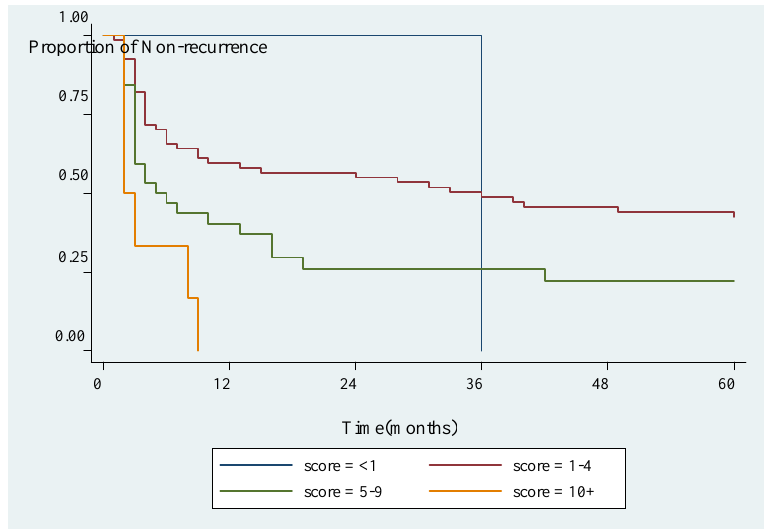
FIGURE 1. Time to first recurrence.